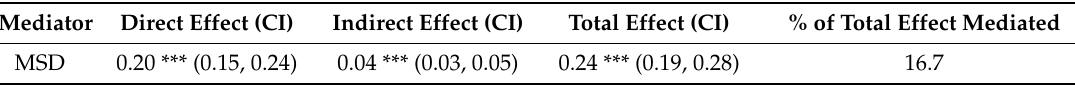
Table 3. Total, direct, and indirect effect of adverse social behavior on sickness presenteeism (Mediation model).